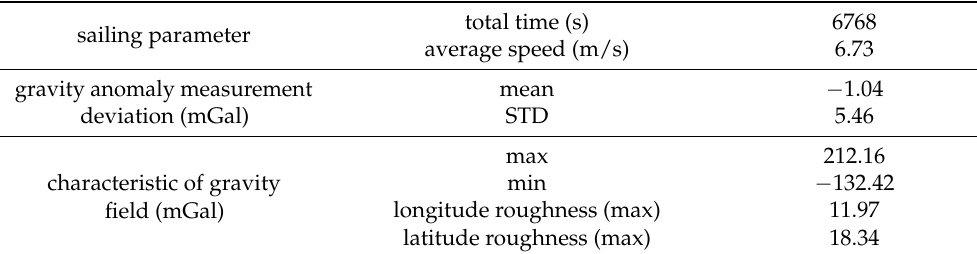
Figure 7. Gravity anomaly measurement and gravity map data. Table 3. Information of the sailing track 2.